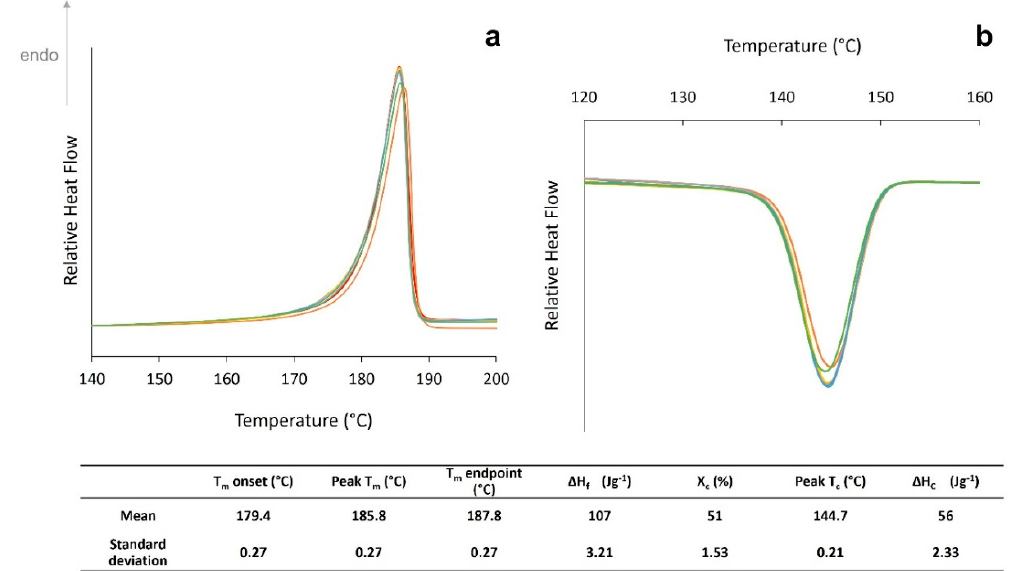
Figure 1. Virgin PA − 12 powder sample variability for ( a ) melting behaviour and ( b ) crystallisation Figure 1. Virgin PA-12 powder sample variability for ( a ) melting behaviour and ( b ) crystallisa- behaviour. tion